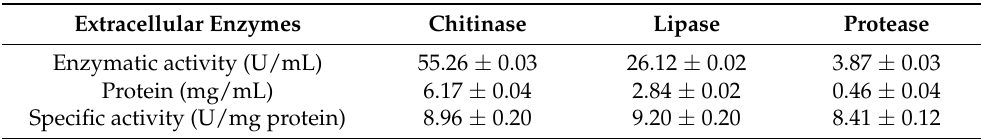
Table 3. Evaluation of the enzymatic activities of endophytic bacterium Pseudomonas putida strain ASU15. Extracellular Enzymes